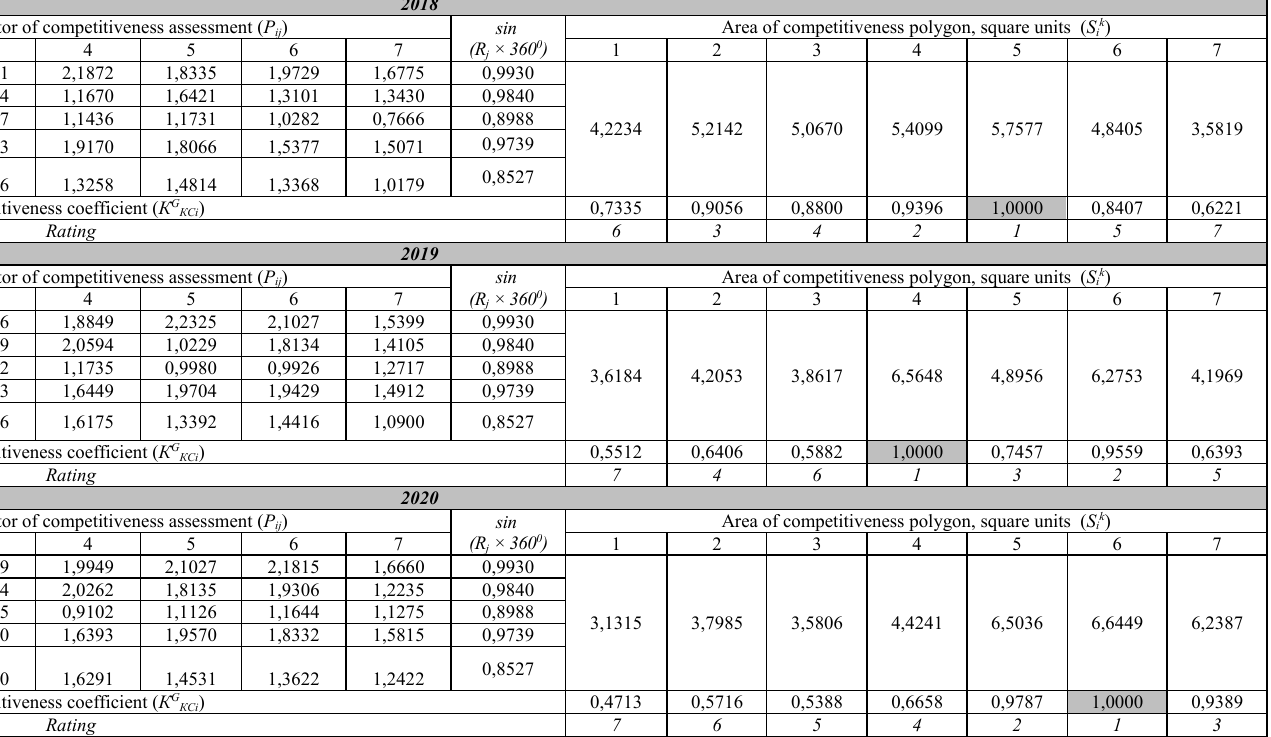
Matrix of graphical assessment of the enterprises’ competitiveness in